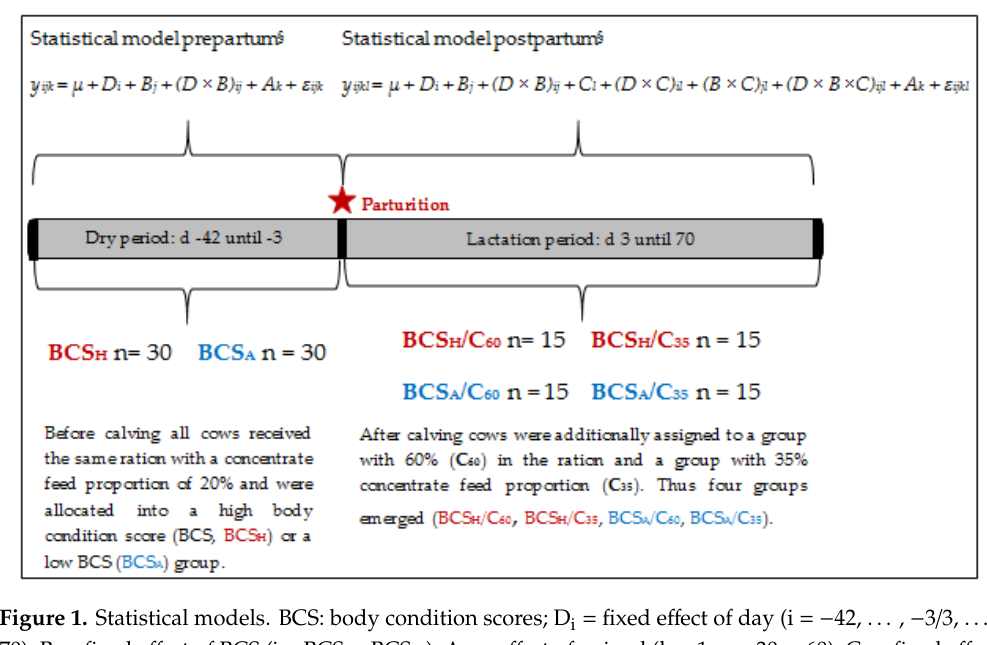
Figure 1. Statistical models. BCS: body condition scores; D i = fixed effect of day (i = − 42, …, − 3/3, …, 70); B j = fixed effect of BCS (j = BCS H , BCS A ); A k = effect of animal (k = 1,…,30,...,60); C l = fixed effect of concentrate feed proportion (l = C 60 , C 35 ); (D × B) ij , (D × C) il , (B × C) jl , (D × B ×C) ijl = fixed effects of respective interactions, ε ijkl = error.